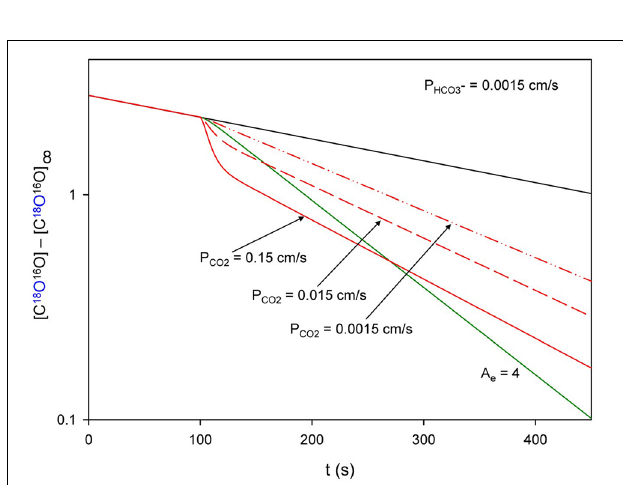
FIGURE 11 | Calculated mass spectrometric recordings for three different conditions of hematocrit and intracellular activity. Blue curve: human red cell hematocrit of 0.02% with intracellular activity Ai of 20,000. Green curve: hematocrit of 0.2% with Ai = 20,000. Red curve (superimposed to the blue curve): hematocrit of 0.2% with Ai = 2000 and 10 times smaller surface-to-volume ratio S/V, similar to what is exhibited by MDCK cells etc. Y-axis: actual concentration of C 18 O 16 O at a given time minus its concentration [C 18 O 16 O] ∞ after isotopic equilibrium has been reached.